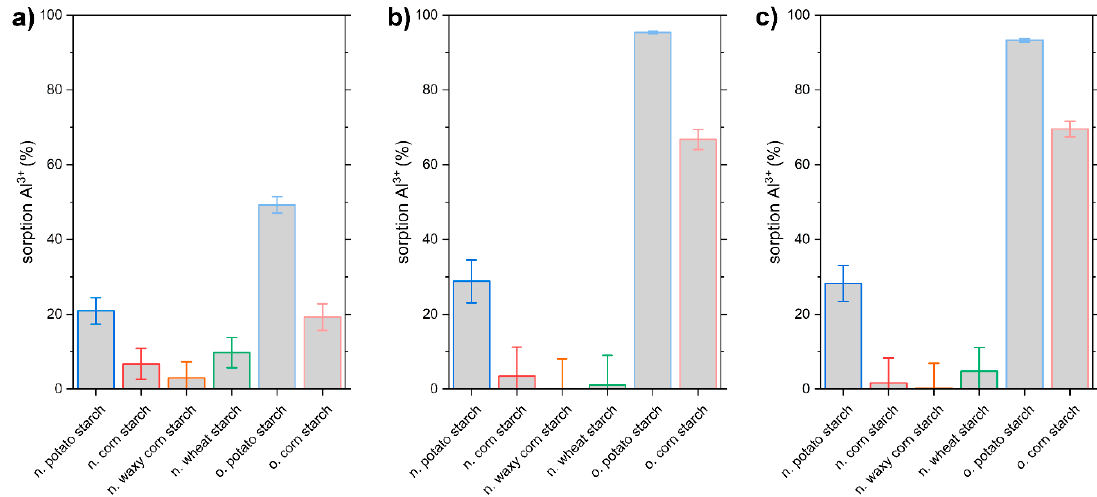
Figure 13. Adsorption experiment with Al 3+ in water samples. ( a ) Adsorption experiment with Al 3+ in water 1 with an initial concentration of aluminum ions of 2.16 mg/L. ( b ) Adsorption experiment with Al 3+ in water 2 with an initial concentration of aluminum ions of 0.84 mg/L. ( c ) Adsorption experiment with Al 3+ in water 3 with an initial concentration of aluminum ions of 0.94 mg/L on native potato starch (blue), native corn starch (red), native waxy corn starch (orange), native wheat starch (green), oxidized potato starch (light blue), and oxidized corn starch (pink). The corresponding pH values for the real water samples are shown in Figures S28–S30 and the corresponding SO 42 − percentage adsorption is shown in Figures S31–S33. The adsorption experiments with water 1 were conducted with an adsorption time of two hours, while 24 h was chosen for water 2 and 3.